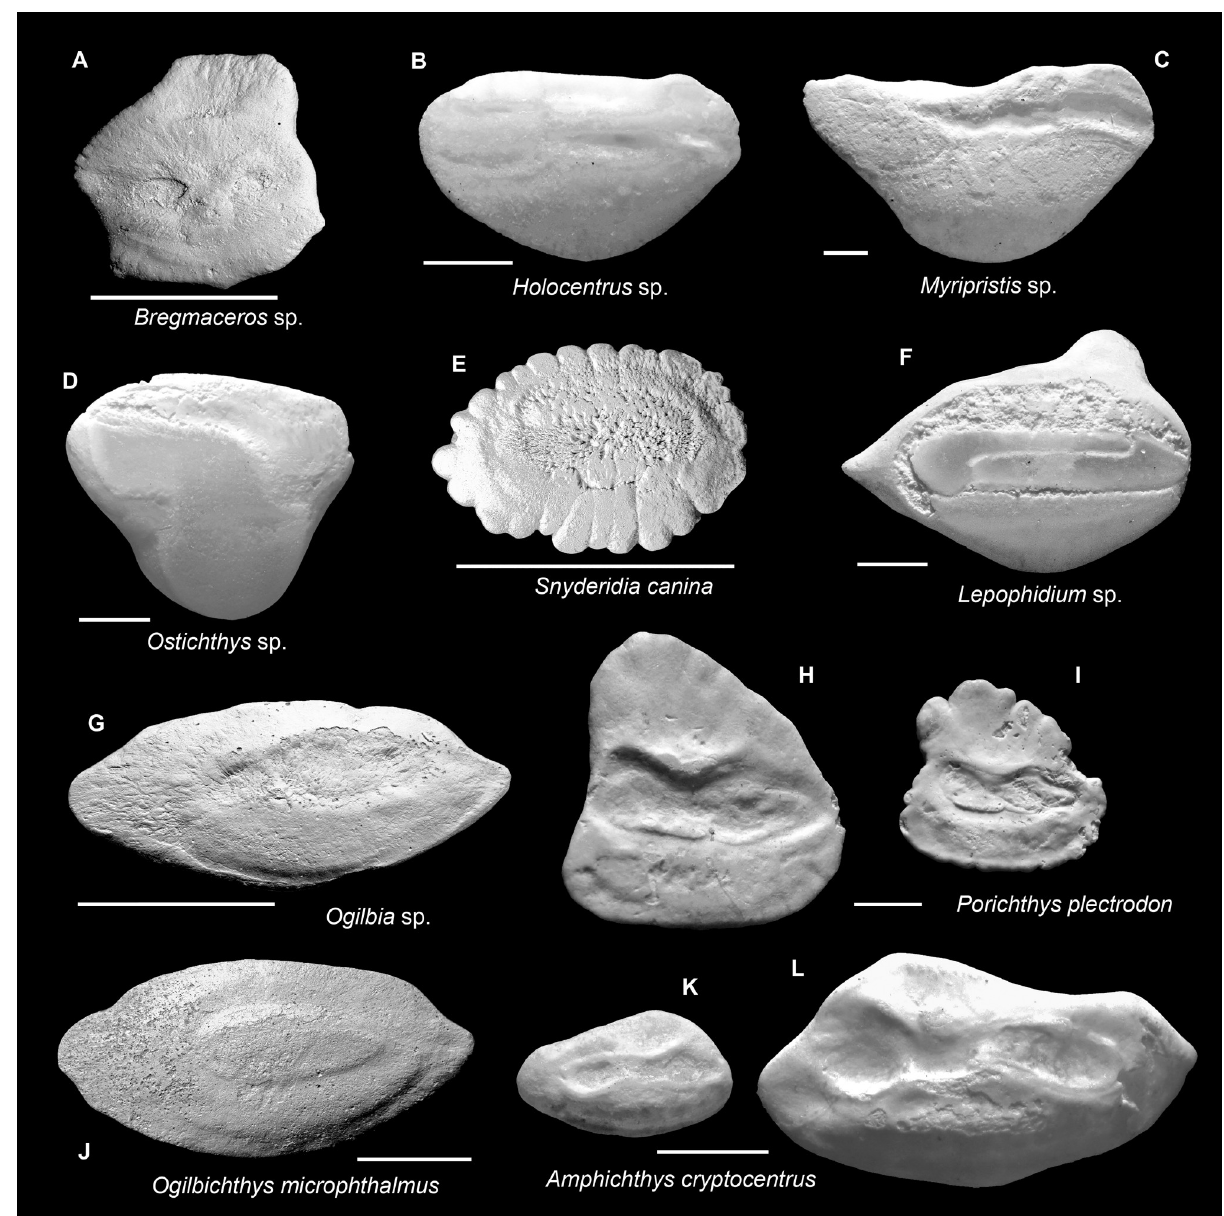
Fig 4. Fish otoliths from the mid-Holocene and sub-Recent reef sediments. Images are inner views and scale bars = 1 mm. A. Bregmaceros sp., left otolith, mid-Holocene, Ca ñ on de Buo. B. Holocentrus sp., right otolith, sub-Recent, La Caleta Beach Reef. C. Myripristis sp., right otolith, sub-Recent, Hickory Ship, La Caleta. D. Ostichthys sp., right otolith, sub-Recent, Wreck Limon La Caleta. E. Snyderidia canina , left otolith, sub-Recent, Playa Estrella. F. Lepophidium sp., left otolith, sub-Recent, Cayo Levantado, Samana Bay. G. Ogilbia sp., left otolith, sub-Recent, La Caleta Beach Reef. H, I. Porichthys plectrodon , left otoliths, H, sub-Recent, SW Bocas Island; I, mid-Holocene, Sweet Bocas Trench 8. J. Ogilbichthys microphthalmus , left otolith, sub-Recent, Hickory Ship La Caleta. K, L. Amphichthys cryptocentrus , sub-Recent, K, left otolith, Cayo Adriana; L, right otolith, STRI Point. a much wider and longer sulcus, a marked constriction at the collum of crista superior, and a wider ventral rim relative to the dorsal rim. The varied shapes in the dorsal rim of our Por- ichthys specimens, each from the mid-Holocene and sub-Recent sample of Bocas, is here con- sidered ontogenetic differences [62]. They are very similar to the upper Miocene (Cercado